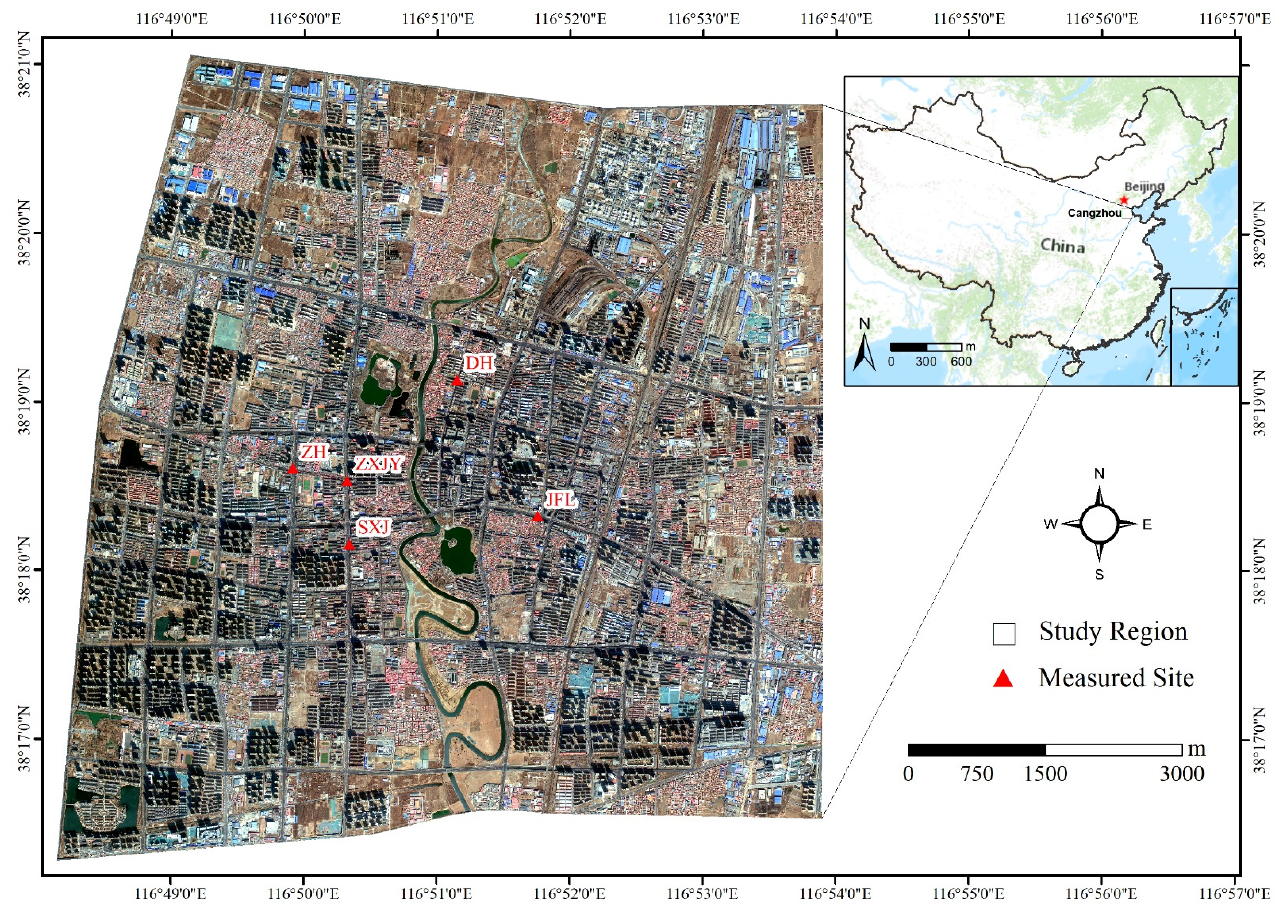
Figure 1. The locations of the measured sites in the study area.